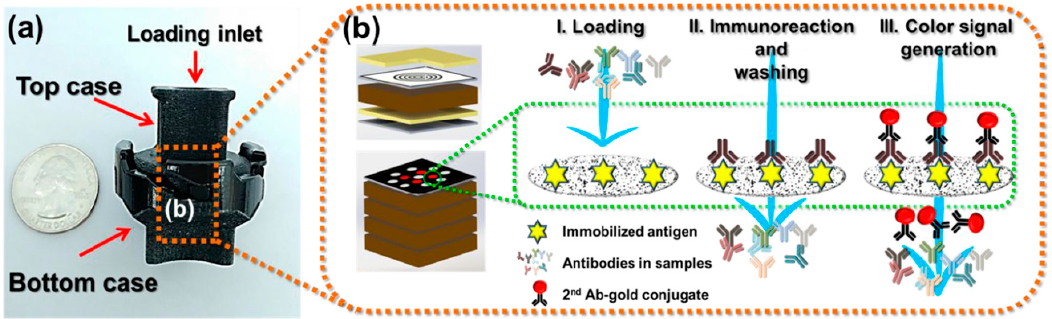
Figure 3. Vertical Flow Assay (VFA) device showing ( a ) assembled device relative to an American quarter ( b ) the general assay procedure, from sample addition to eventual sample color generation. Reprinted from ref [41], with permission from the Royal Society of Chemistry.